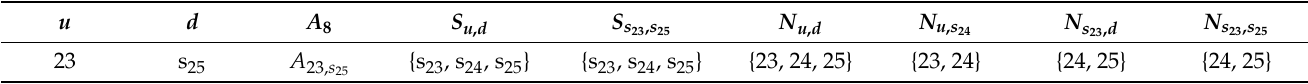
Table 3. Correspondence of the notation of area A 8 .